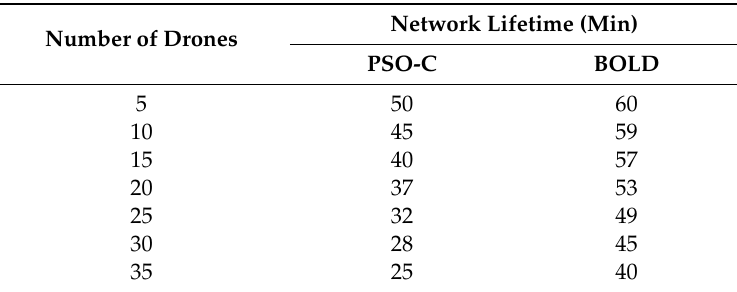
Table 7. Network lifetime vs number of